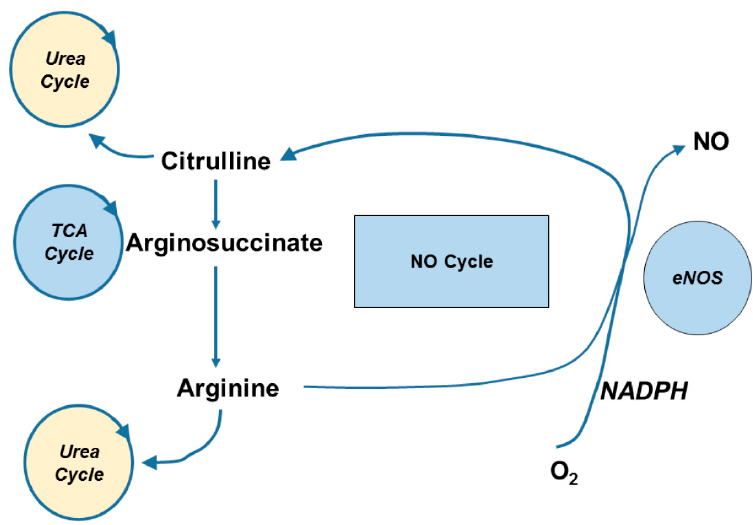
Figure 2. Nitric Oxide (NO) Cycle. Schematic representation of the NO cycle.